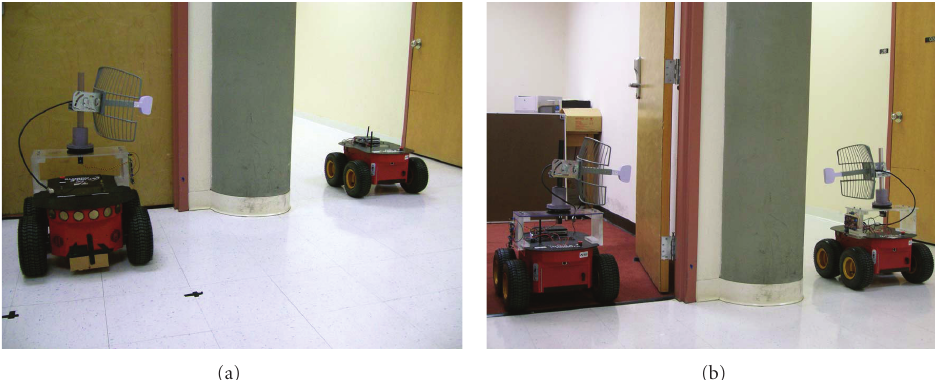
Figure 12: (a) Pioneer robots gathering data at the basement of the ECE building at UNM with the transmitter using an omnidirectional antenna and the receiver using a directional one. (b) Pioneer robots using directional antennas for both transmission and reception.